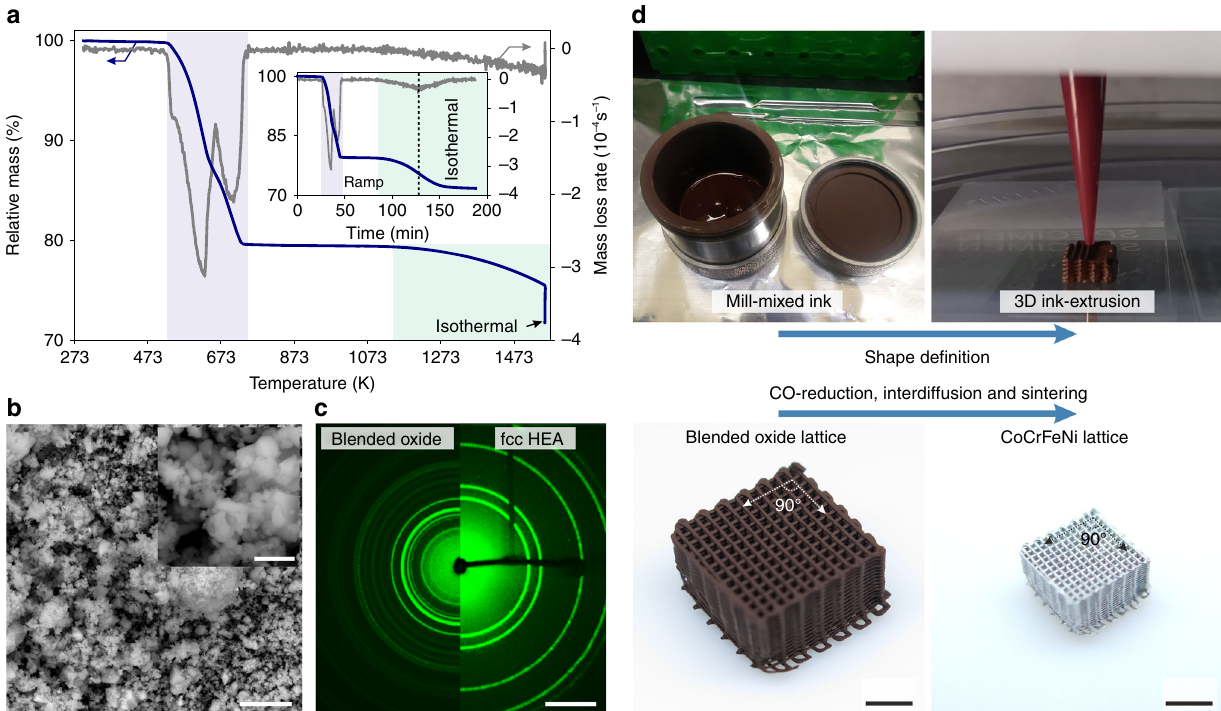
Fig. 1 Creating CoCrFeNi high-entropy alloys via 3D ink-extrusion, reduction and sintering of oxide powder blends. a TGA mass loss of a loose blend of Co 3 O 4 + Cr 2 O 3 + Fe 2 O 3 + NiO as function of temperature in a H 2 atmosphere. Initial reduction of Co 3 O 4 , Fe 2 O 3 and NiO (blue shading) is followed by reduction of Cr 2 O 3 (green shading). Inset: Same data as function of time, showing ramp and 1 h hold at 1557 K, when continuous mass loss occurs due to ongoing reduction of Cr 2 O 3 until it is fully consumed. b Scanning electron micrograph of the blended oxide powder prior to TGA, showing agglomerate sizes <10 μ m and sub-micron particle size. Scale bars are 5 µ m and 1 µ m (inset). c Combined 2D diffractograms of blended oxide prior (left) and after (right) the TGA measurement in H 2 showing the complete disappearance of all oxide-related diffraction intensities and formation of a face-centered cubic CoCrFeNi HEA. Scale bar is 20 nm – 1 . d The two-step processing route fi rst shapes the mill-mixed ink using 3D ink-extrusion into the desired architecture (a micro-lattice with 200 µ m diameter struts, in the present example). In a second step, the powders in the green body are co-reduced, inter-diffused and sintered to yield a CoCrFeNi HEA micro-lattice with much smaller overall dimensions and strut diameter, without warping or cracking. Scale bars are 3